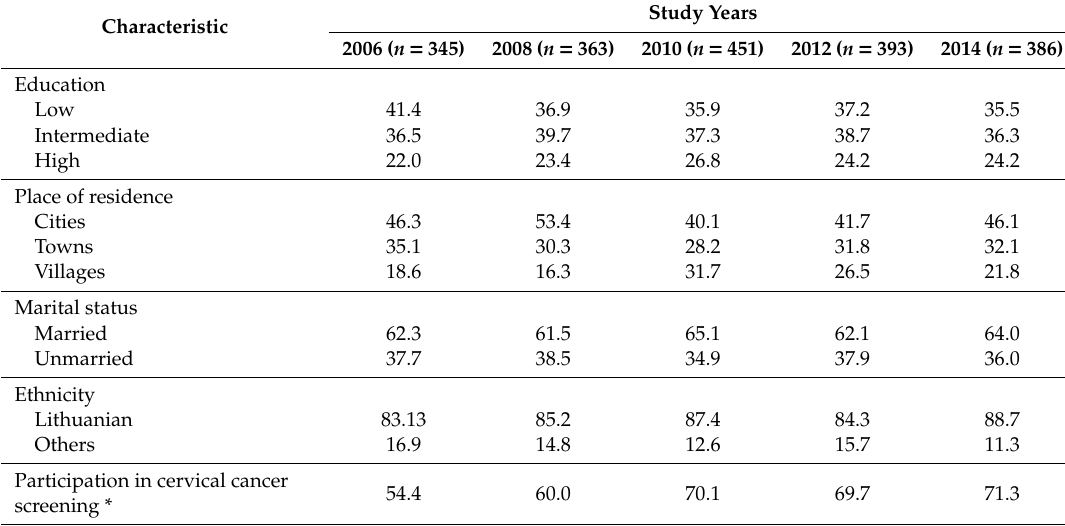
Table 1. Characteristics of the study population